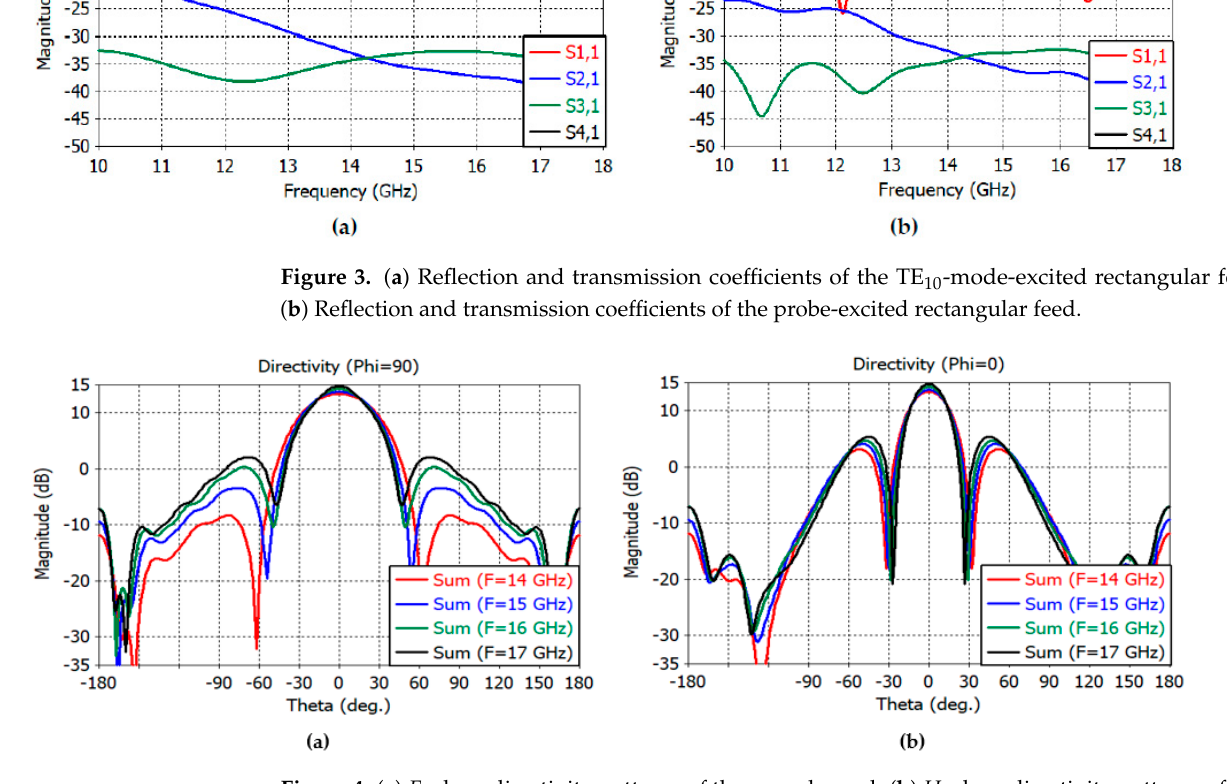
Figure 4. ( a ) E -plane directivity patterns of the sum channel. ( b ) H -plane directivity patterns of the sum channel.